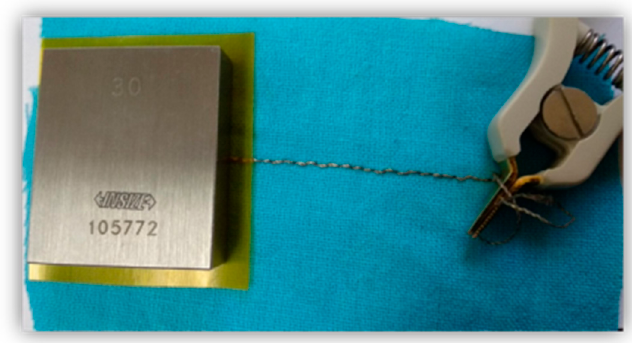
Figure 6. Scheme for the capacitance measurement.